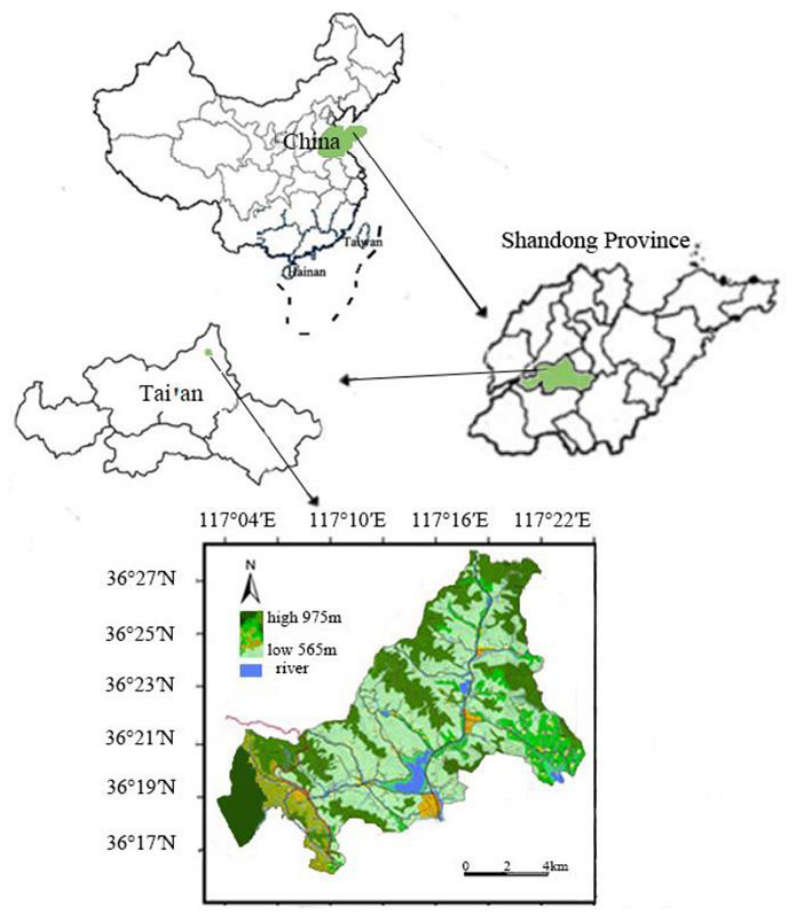
Figure 1. Map of the location of the study area.